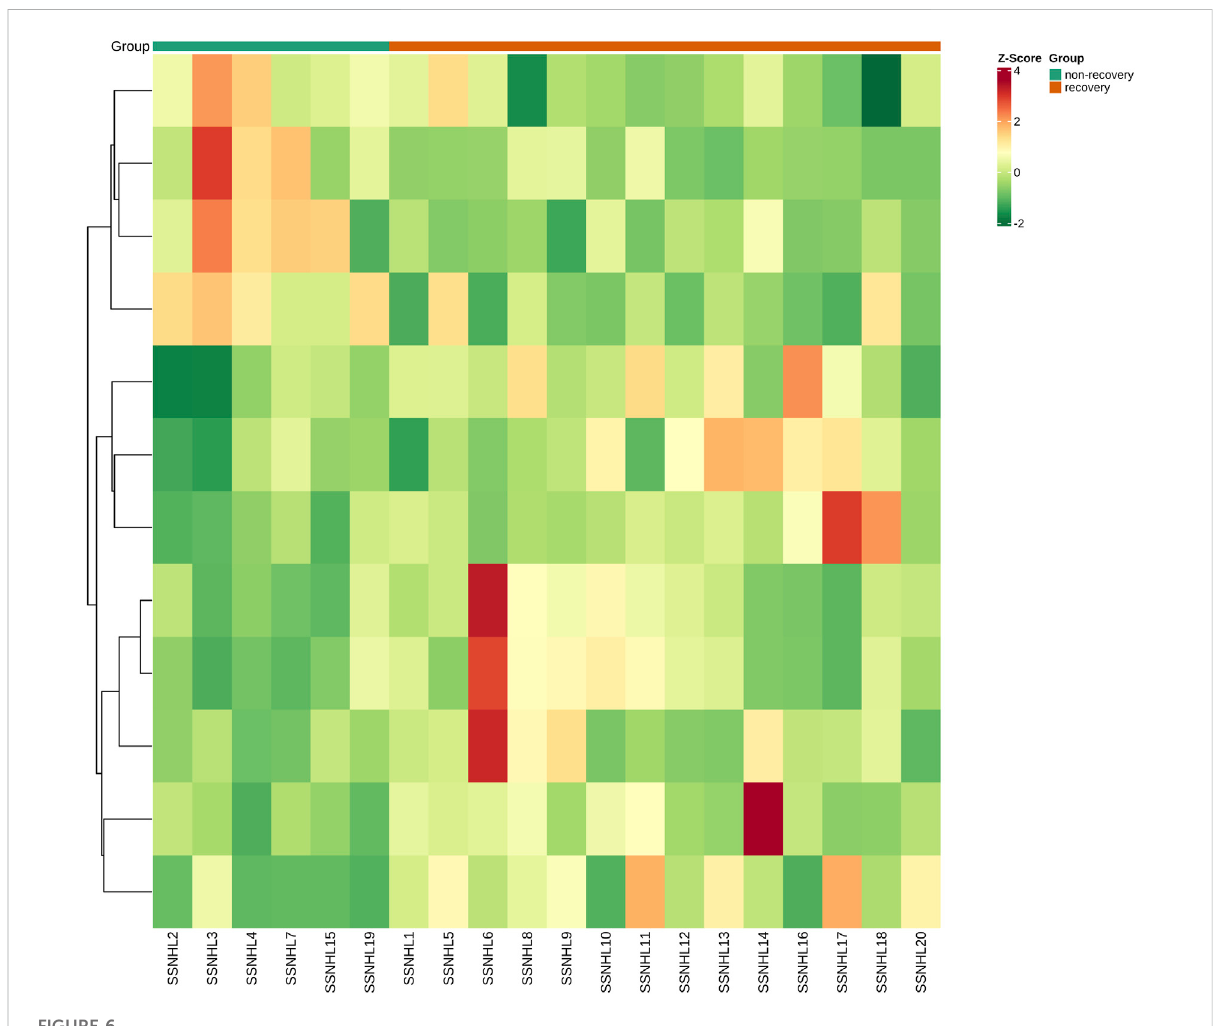
FIGURE 6 Heat map of the 12 discriminative metabolites between recovery and non-recovery